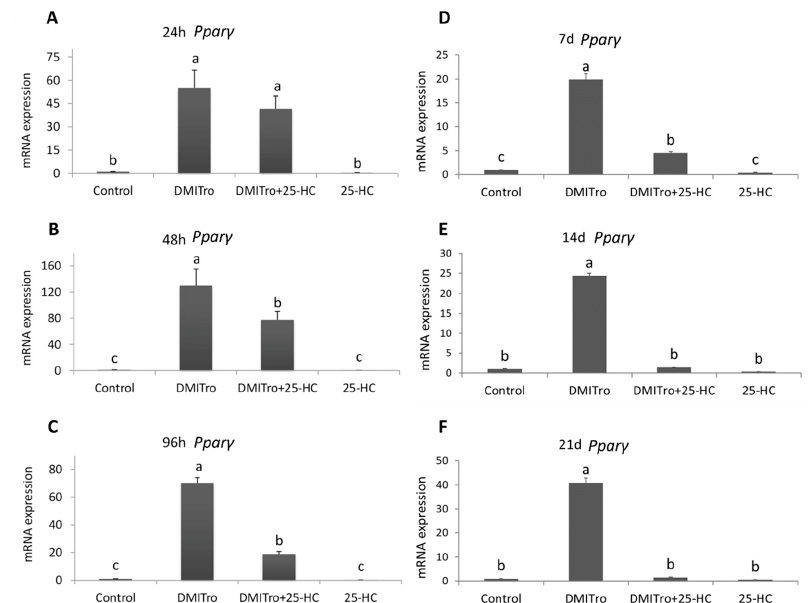
Figure 3. The effects of 25-HC on the expression of Ppar γ mRNA at different time points: ( A ) 24 hours, ( B ) 48 hours, ( C ) 96 hours, ( D ) 7 days, ( E ) 14 days, ( F ) 21 days. C3H10T1/2 cells at confluence were treated with a control, DMITro (500 nM DEX, 0.5 mM IBMX, 20 µg/mL Insulin and 10 µM Tro), DMITro + 10 µM 25-HC or 25-HC alone for 24 h, 48 h, 96 h, 7 days (d), 14 days and 21 days. The results show the average values of three replicates ( n = 3) and the SD of the means. Bars with the same letter are not significantly different. Int. J. Mol. Sci. 2019 , 20 , x FOR PEER REVIEW